Question: Express in one sentence what the figure is showing.
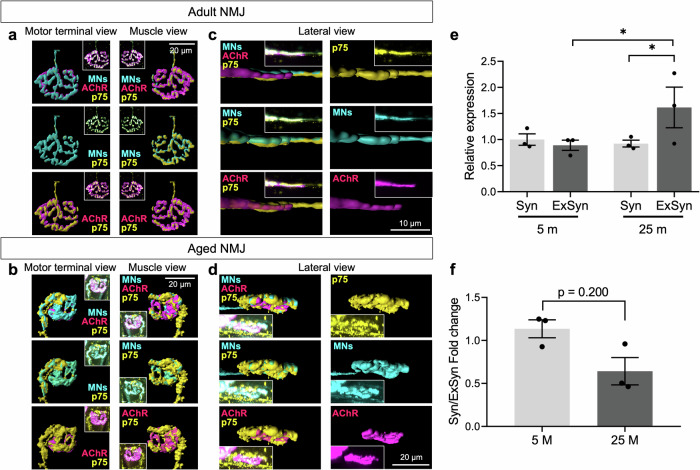
Answer: p75 is expressed at the aged NMJ. Whole-mount lumbrical muscles from control adult (5-mo-old) ( a , c ) and aged (24–26-mo-old) ( b , d ) mice were immunostained to reveal the motor axon terminal (2H3 + SV2 antibodies; cyan), AChRs (BTX; magenta), and p75 (yellow). Images acquired as z-stacks were 3D reconstructed using IMARIS software. Left panels show the 3D motor terminal view and the corresponding rotated muscle view of representative NMJs ( a , b ). The right panels show a 3D reconstructed lateral view of a representative NMJ region. Insets show non-3D-processed immunostainings. e p75 mRNA expression quantification relative to GAPDH in synaptic (Syn) and extrasynaptic (ExSyn) regions of the diaphragm from adult and aged mice. f Relative p75 mRNA expression in synaptic vs. extrasynaptic regions from adult and aged mice. Results are shown as mean ± SEM (bars) with individual values (dots; N = 3–4 mice). One-way ANOVA ( e ) and Mann-Whitney test ( f ) were performed. n.s. = non-significant. Scale bar = 20 µm ( a , b , d ) and 10 µm ( c ).